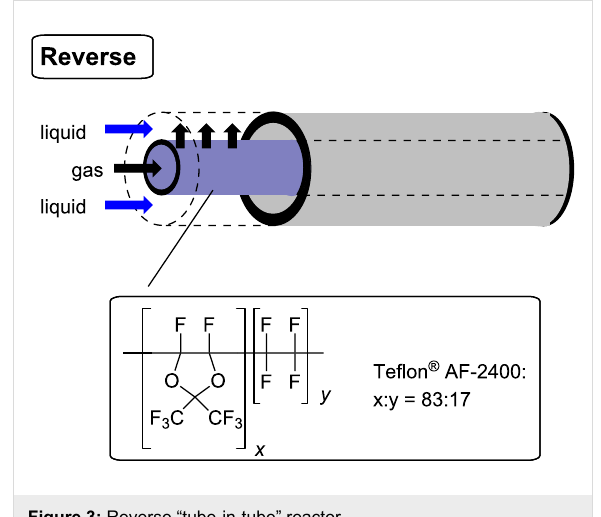
Figure 3: Reverse “tube-in-tube”